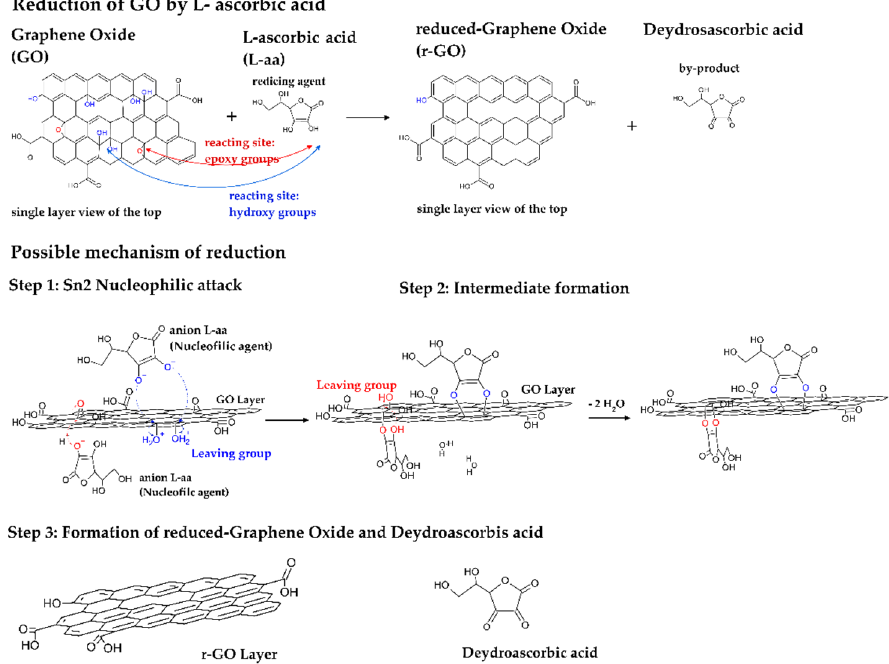
Figure 4. Schematic representation of the reaction pathway [67].